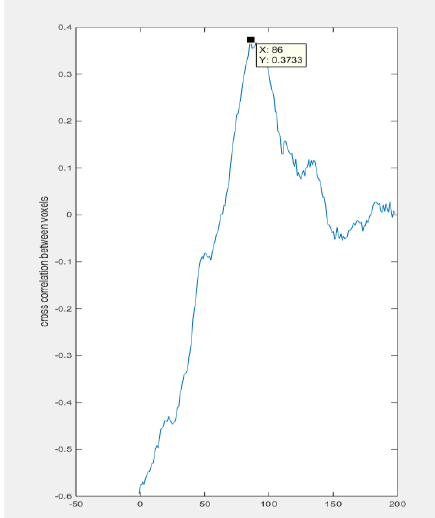
Figure 16. The cross-correlation results: the x -axis indicates the frame number, and the y -axis gives the value of the cross-correlation result. The peak value on the x -axis in this case indicates the transit time of this movement.